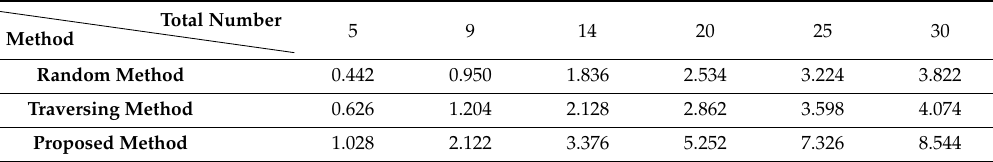
Table 2. Comparison of the numbers of targets found using static Figure 7. The initial stage of the v-shaped formation search.